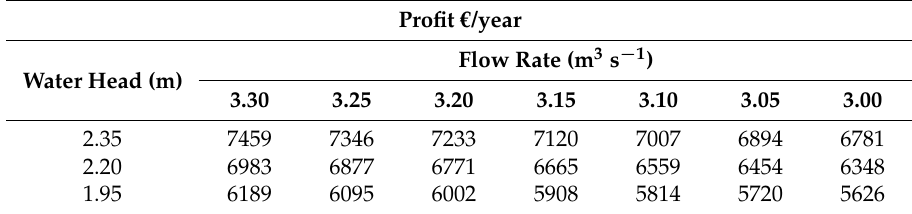
Table 2. Annual profit estimate of SHP electricity production depending on changes in flow rate and water